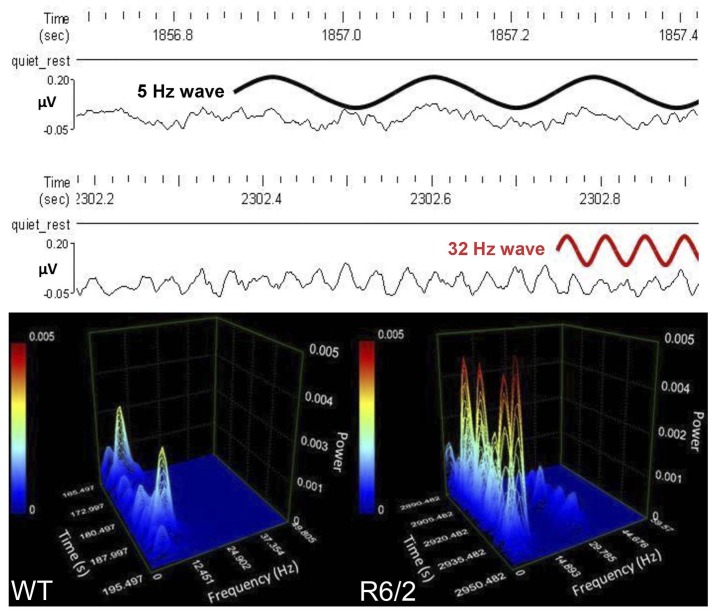
Exemplar raw LFP data from WT (black wave) and R6/2 (red wave) dorsal striatum and accompanying power spectral density (PSD) during quiet rest.Upper panel shows the raw LFP time series with accompanying waveforms that illustrate the strong presence of WT oscillations at low frequencies of ∼5 Hz (top) and characteristic ∼32 Hz (bottom) oscillations in R6/2. Lower panels show the accompanying PSD results as a time-frequency plot. The low-gamma oscillation at ∼32 Hz is characteristic of R6/2 LFPs and persists over time during quiet rest, but is not present in WT.